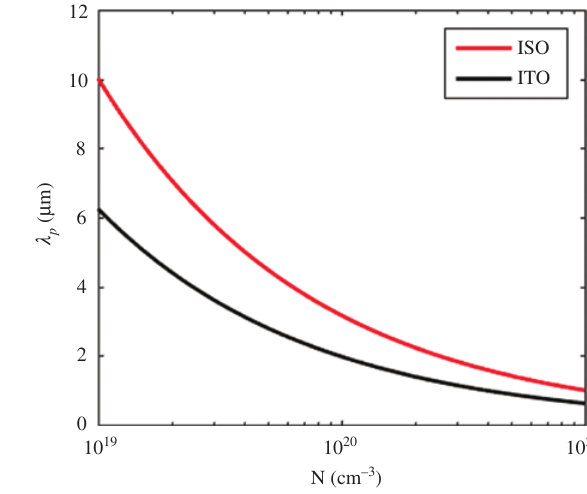
as a function of N for both ITO and ISO with an electron Figure 4: λ p effective mass ( m * ) of m * = 0.35 m